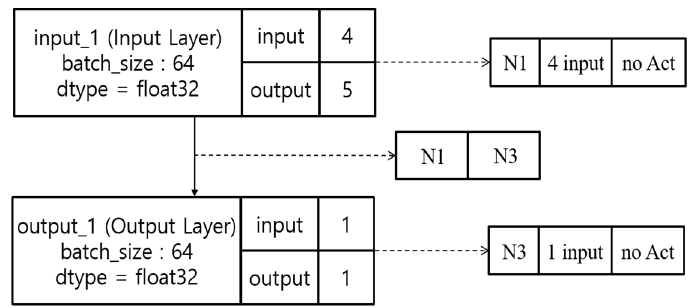
Figure 6. Evolution process of English grammaticality task.